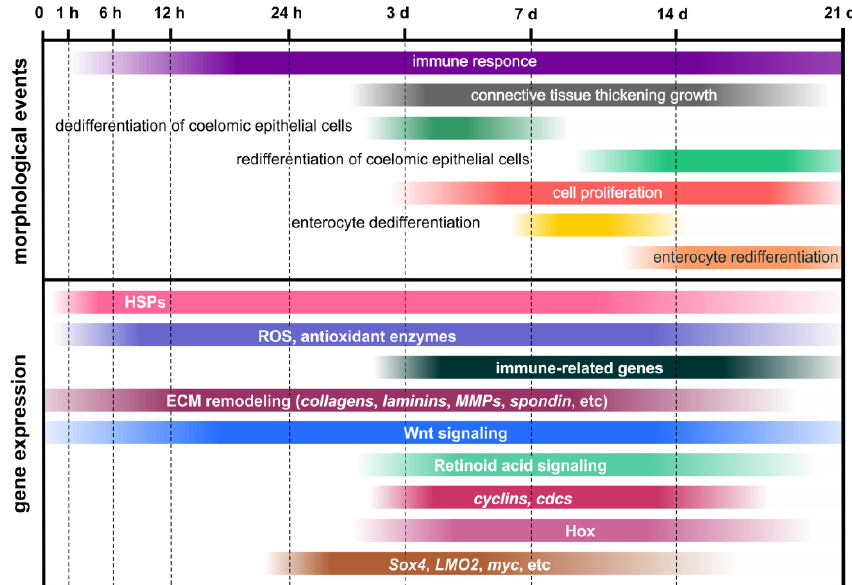
Figure 3. Schematic representation of morphological and molecular events during visceral regen- eration after posterior evisceration. Timeline is represented by hours and days of regeneration after evisceration.